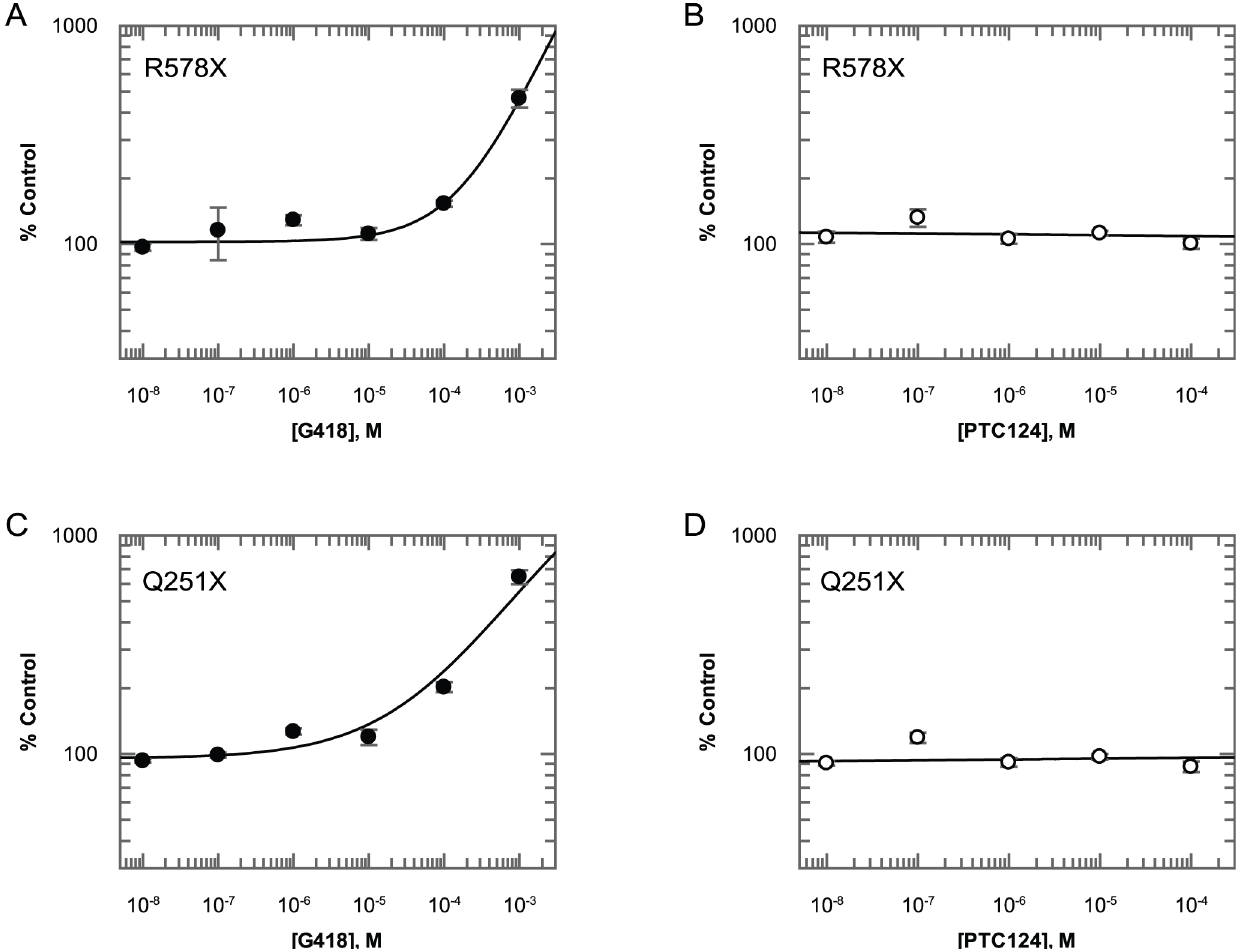
Figure 4. Lack of PTC124 efficacy with transiently transfected collagen VII PTC reporters. Dose-dependent increases in detectable protein with G418 but not PTC124 in R578X (A and B) and Q251X (C and D) PTC collagen VII constructs. All data points represent mean 6 standard deviation (n=4).